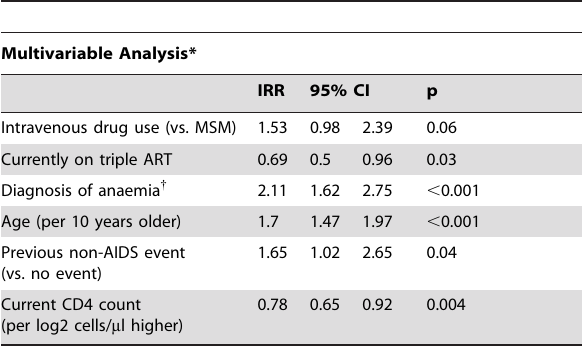
Table 3. Other factors associated with fatal and non-fatal non-AIDS (only factors with p , 0.1 are